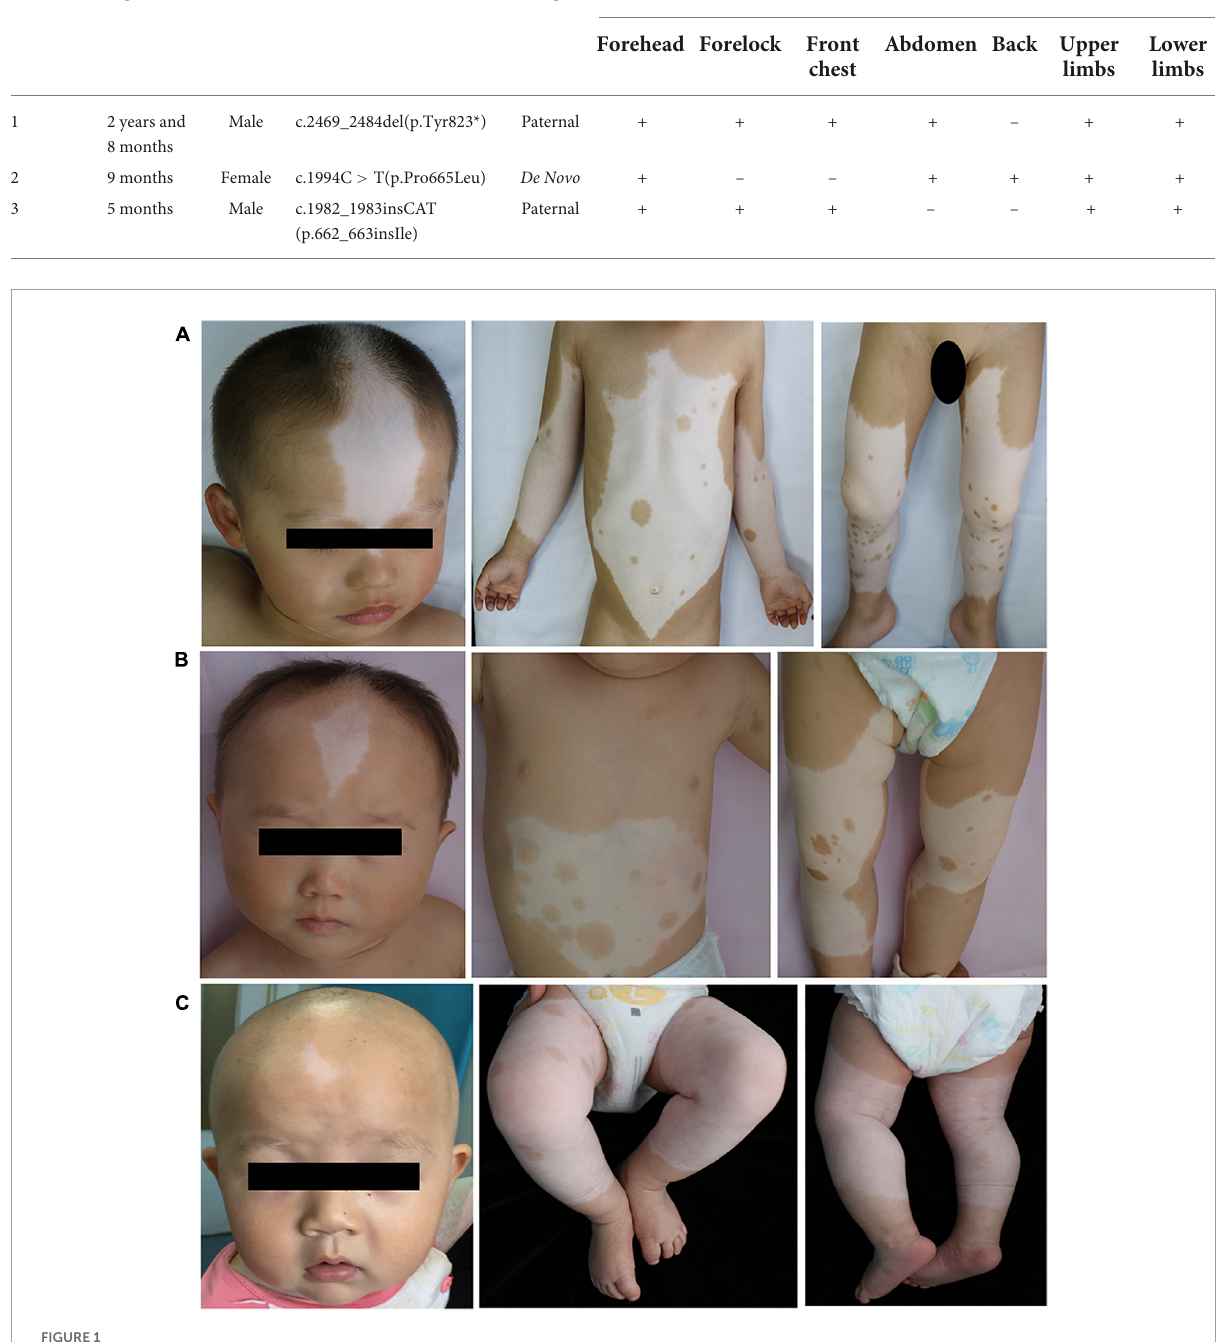
FIGURE1 Main clinical manifestations of the three patients. Depigmented patches were involved in middle frontal, chest, abdomen, limbs of the patient 1 (A) , 2 (B) and 3 (C) . Normal pigment islands were scattered on trunk, and extremities. Café-au-lait macules were noticed on the right lower limb of Patient 1 and the front chest, left armpit, right lower limb of Patient 2.